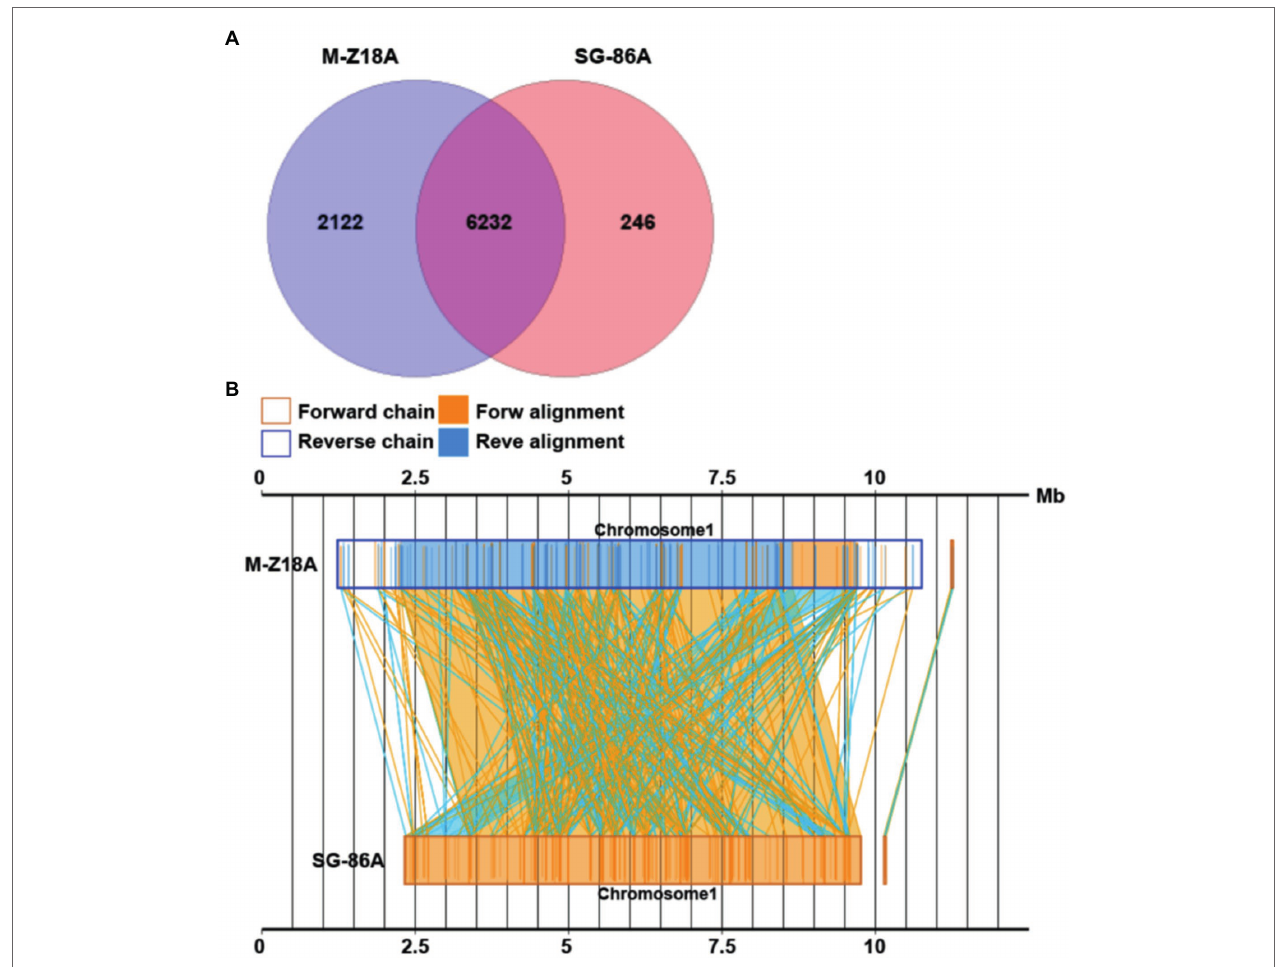
FIGURE 4 | Venn diagram showing the number of core genes and pan genes for two strains (A) . Syntenic dot plot of two strains (B)